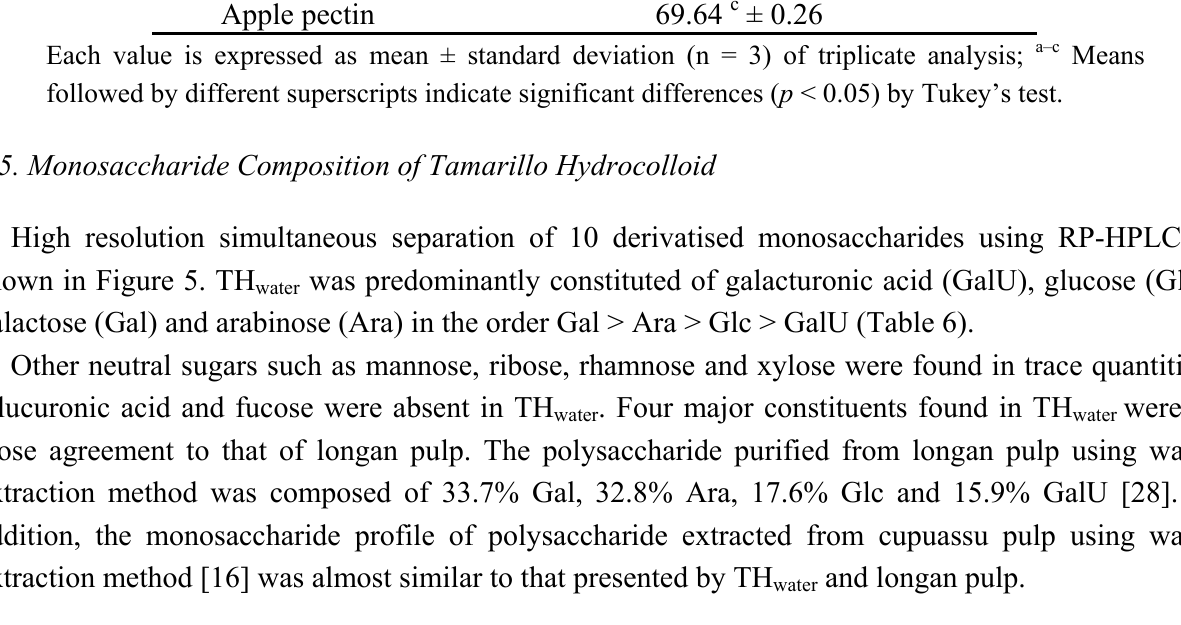
), apple and citrus water